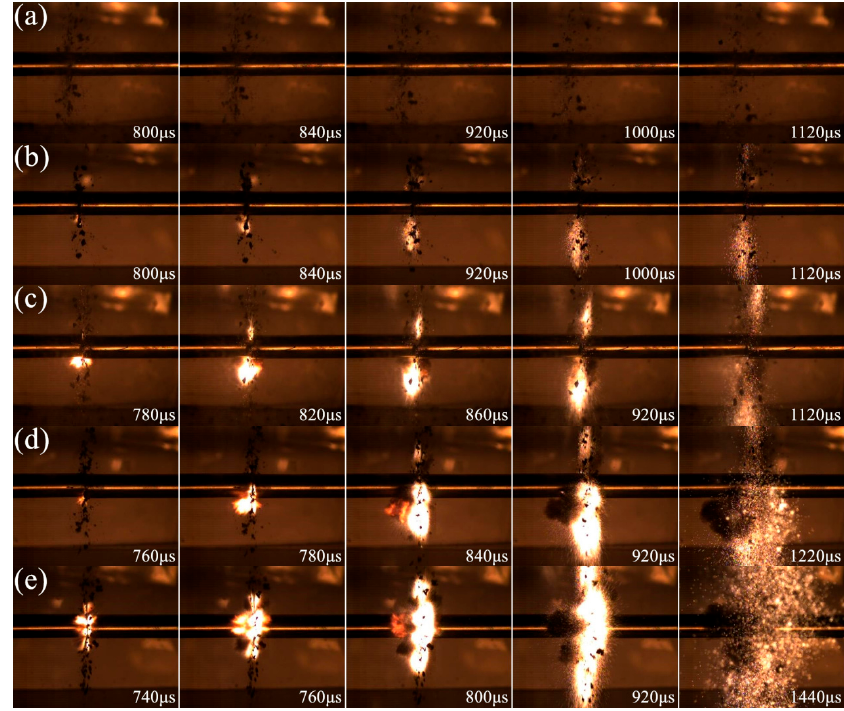
Figure 11. Video frames of 68PTFE/32Ti composites captured under different strain rates: ( a ) 4240 s − 1 ; ( b ) 4620 s − 1 ; ( c ) 5400 s − 1 ; ( d ) 5980 s − 1 ; ( e ) 6400 s − 1 .